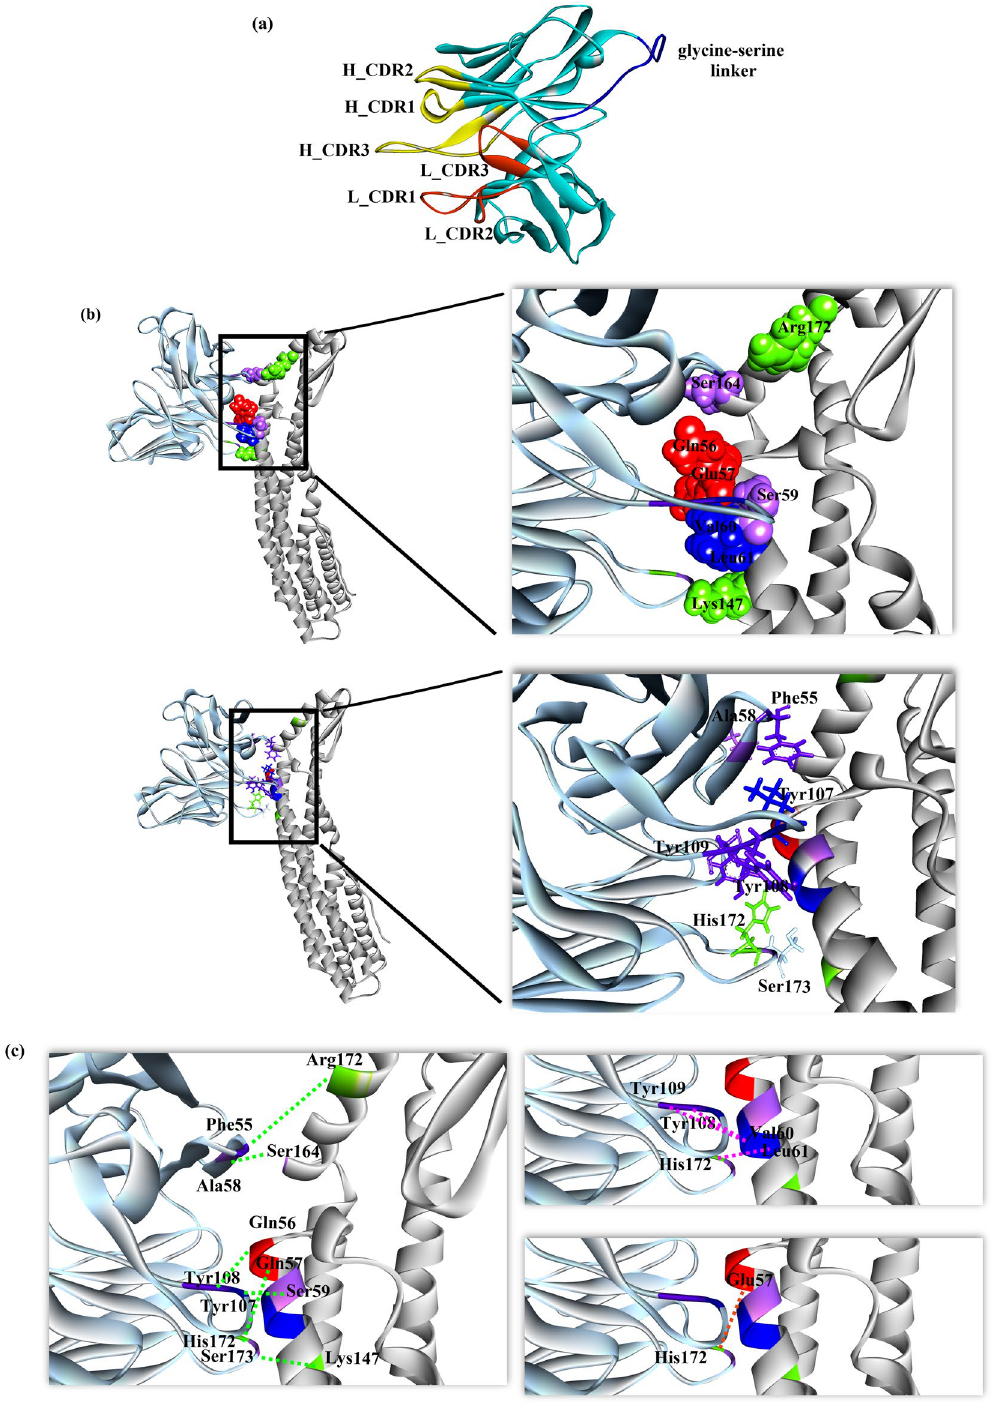
Figure 6. Structural analysis of HlyE conformational epitope. ( a ) 3D model of mAb_C_C2 scFv; ( b ) docking pose of mAb_C_C2 (blue) with conformational epitope of HlyE (grey) and the insight view of mAb_C_C2 (blue) binding to conformational epitope of HlyE (grey). The contacting residues are in stick (paratope) and CPK (epitope) forms; ( c ) interaction between mAb_C_C2 (blue) with conformational epitope of HlyE (grey) with pink, brown and green dotted lines representing hydrophobic bonds, electrostatic interaction and hydrogen bonds